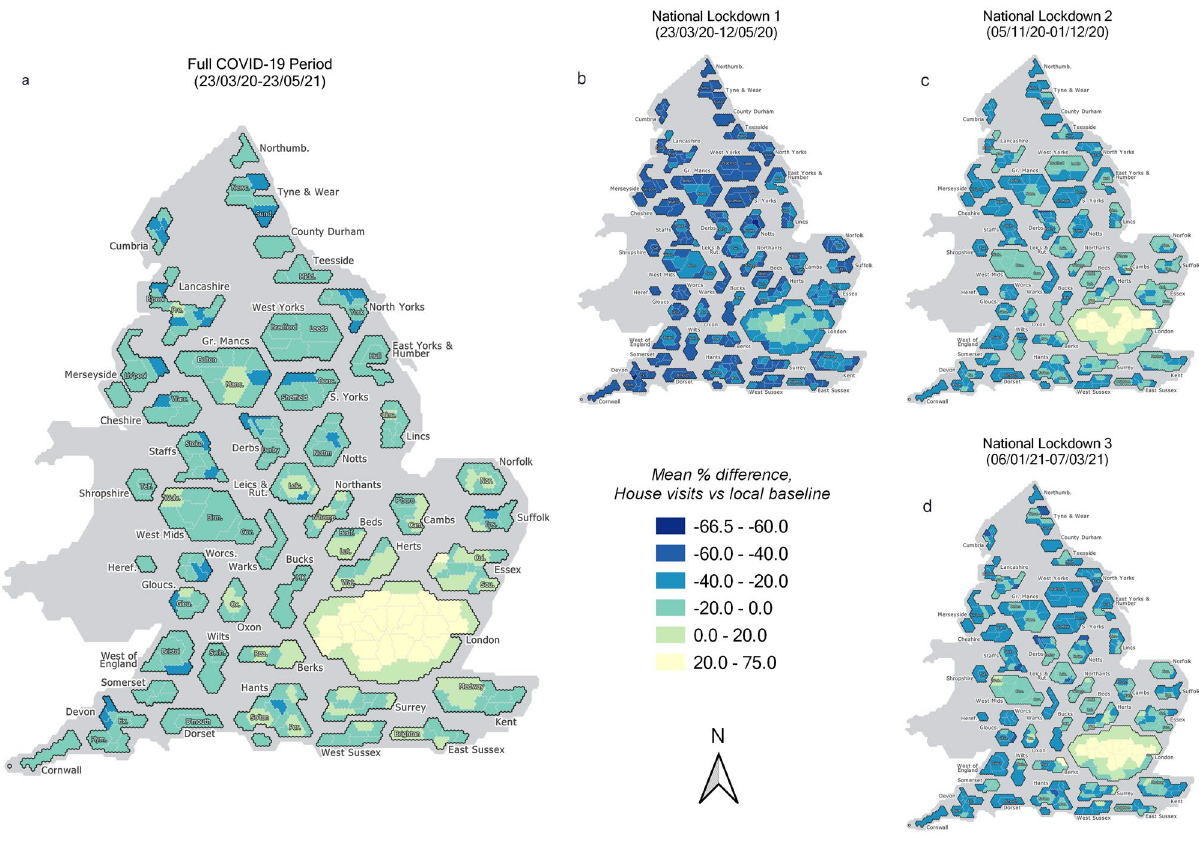
Figure 2. Hexagon-based cartogram distribution in H l , t during ( a ) the England COVID-19 period, and ( b–d ) three national lockdowns. Local authority boundaries are resized by population count to enable greater visibility in more highly dense regions (i.e., cities), and were prepared by the UK House of Commons Library.